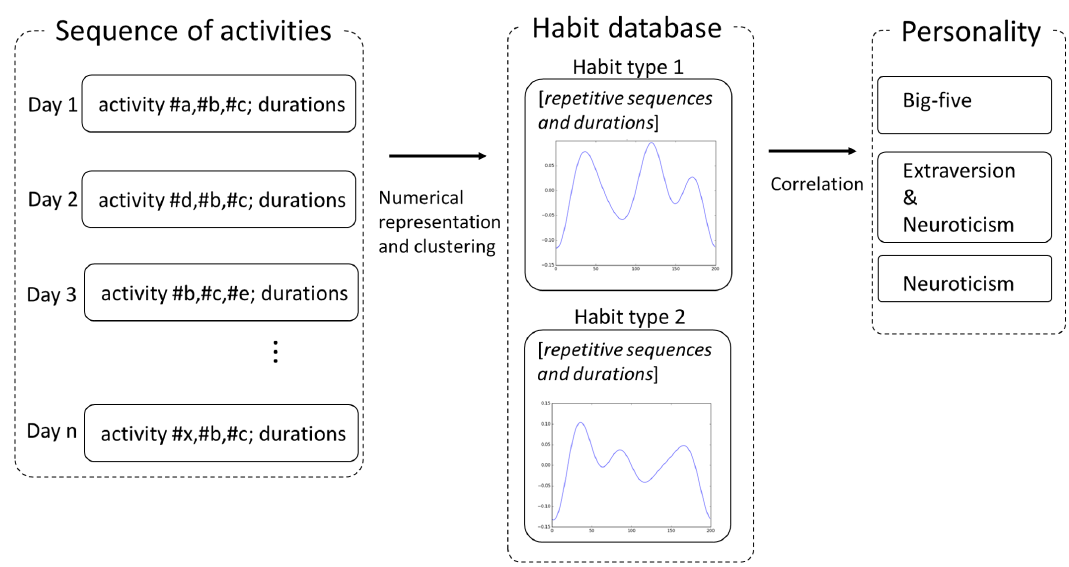
Figure 2. Estimation of personality traits from the sequences of activity